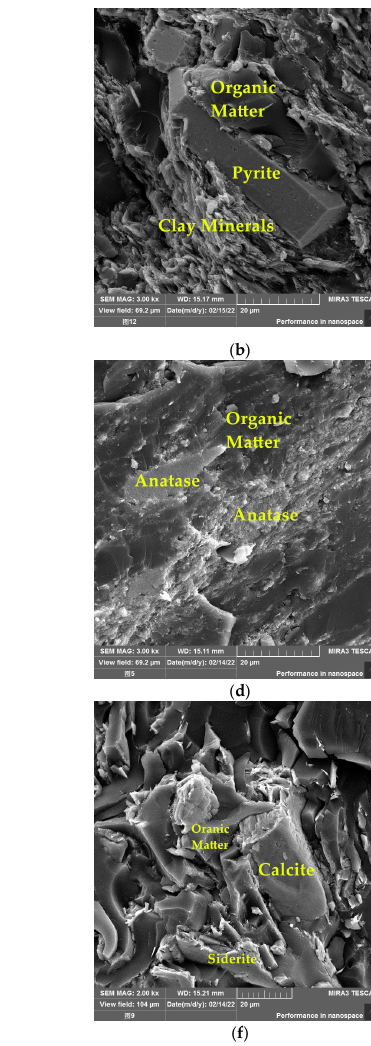
Figure 1. SEM images of minerals in the No. 9 coal and related roof samples from the Xinyuan mine: ( a ) Pyrite in sample XY-D1; ( b ) Pyrite and clay minerals in sample XY-D1; ( c ) Clay minerals in sam-